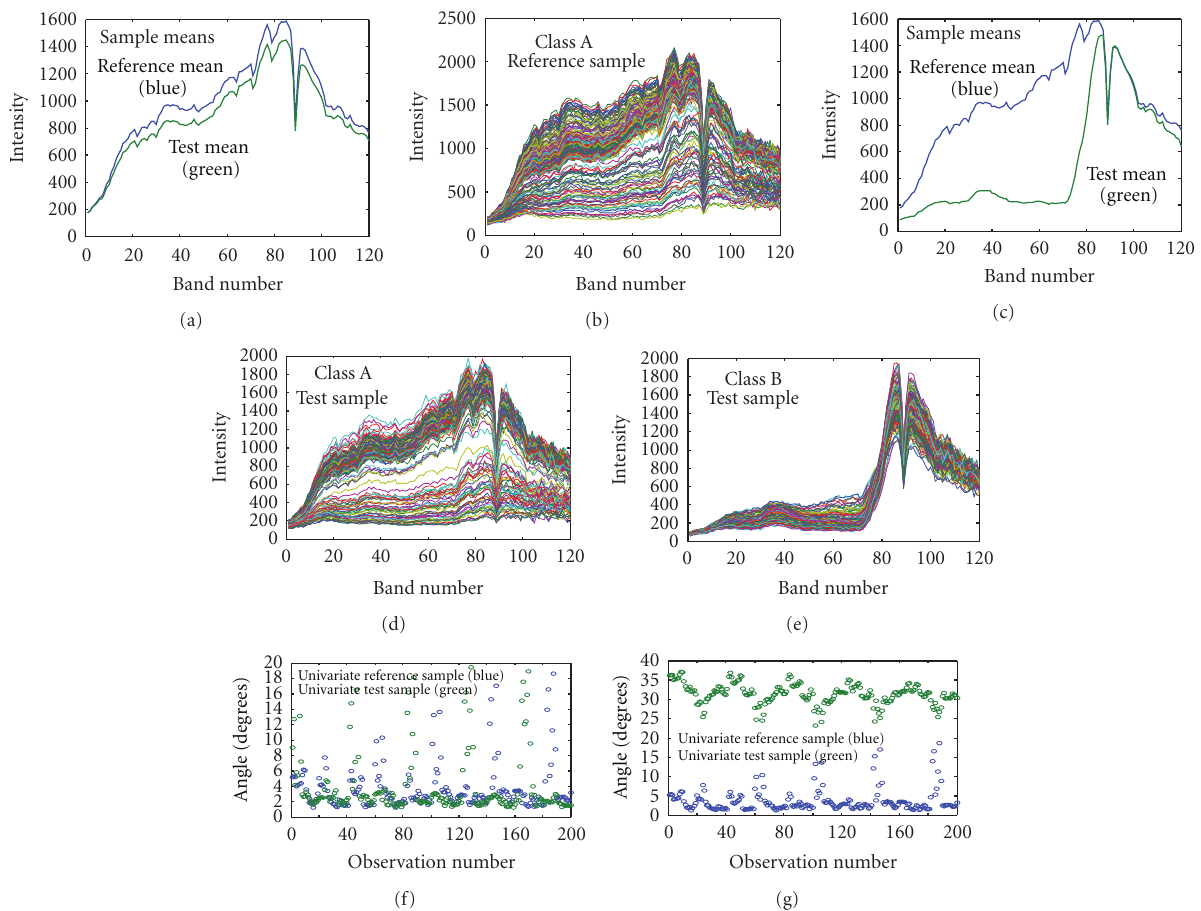
Figure 3: Spectral transformation from multivariate to univariate sample using the actual spectral values instead of spectral di ff